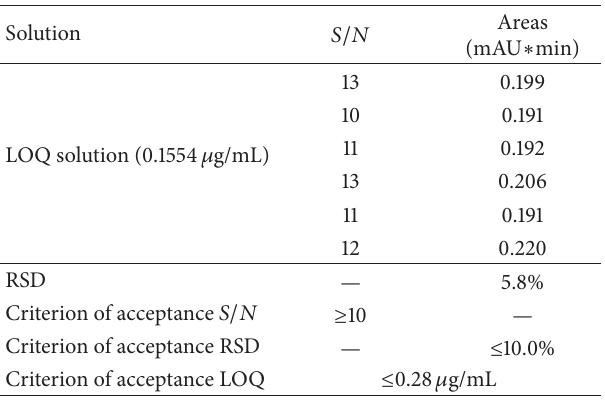
Table 5: Results: practical verification of LOQ.